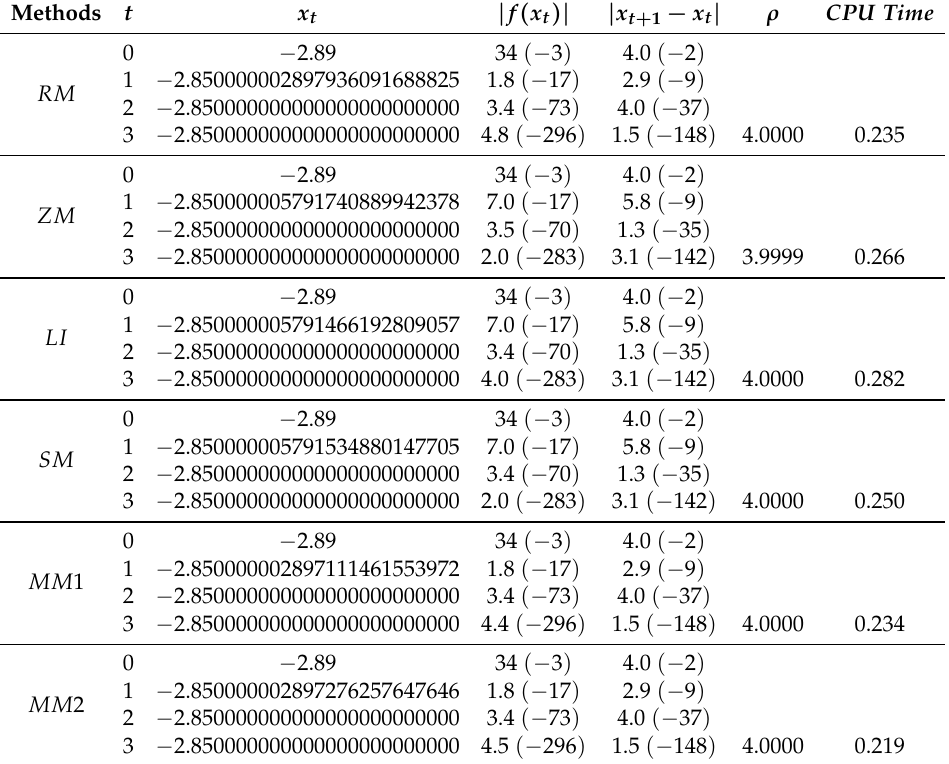
Table 4. Outcomes for comparison by testing schemes on Example